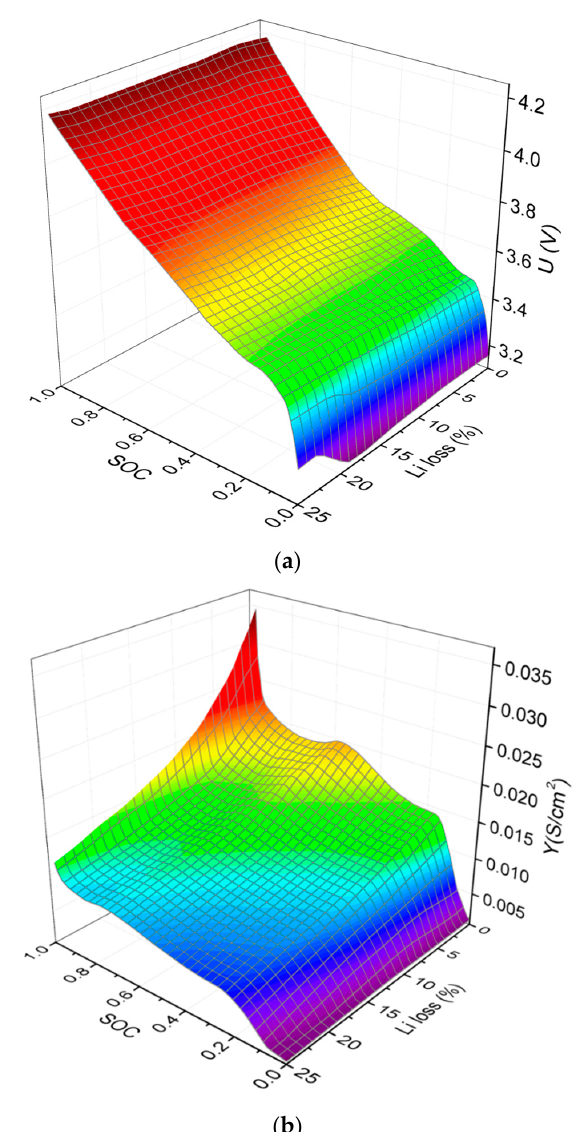
Figure 6. Three-dimensional surface plots of ( a ) U; and ( b ) Y as functions of SOC and of the loss of cyclable